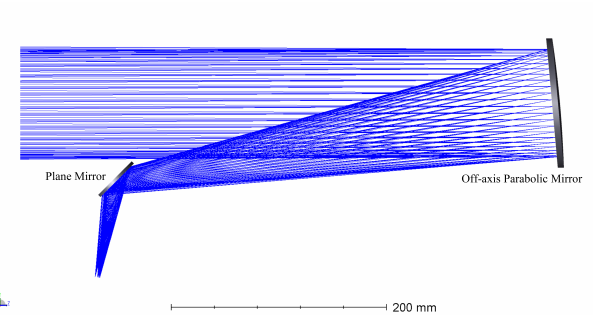
Figure 10. The optical structure of the collimator.